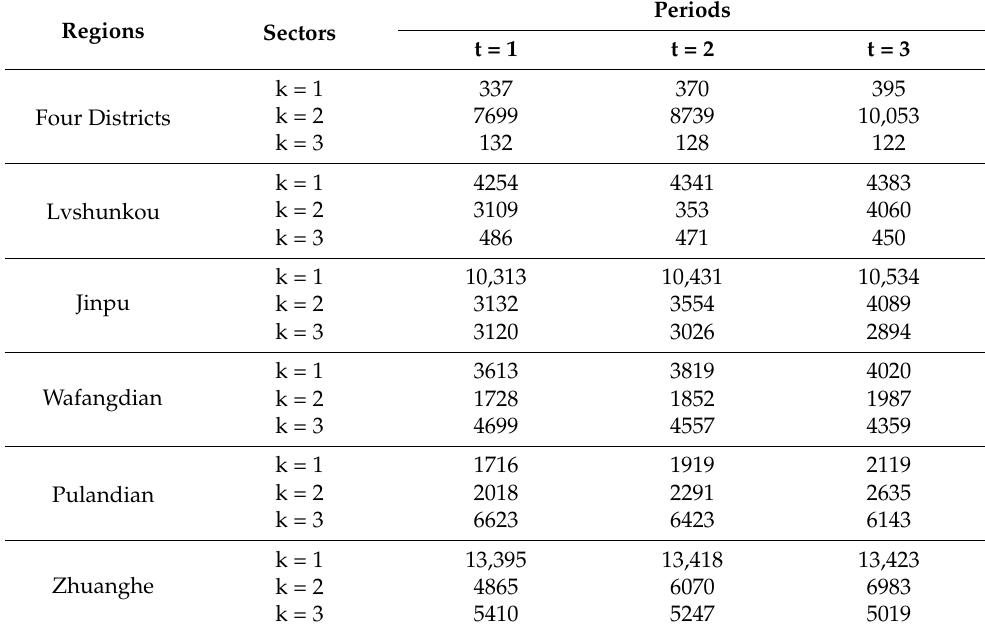
Table 2. The initial optimal allocation of water resources in Dalian (10 4 m 3 /year). Regions